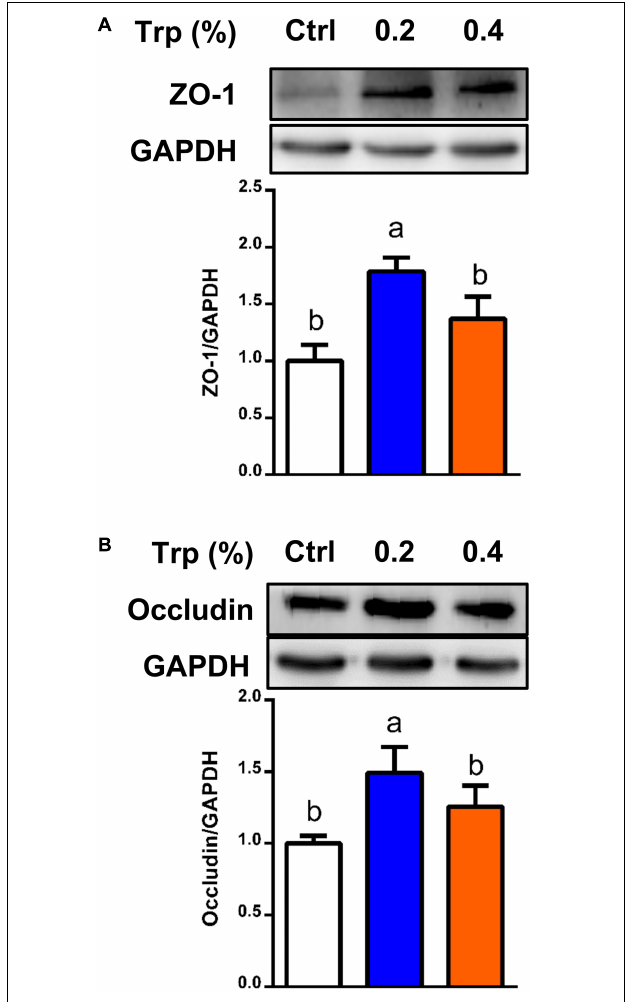
FIGURE 6 | Protein abundances of tight junction in the colon from weaned pigs in 0%, 0.2%, and 0.4% Trp groups. Data are presented on ZO-1 (A) , and occludin (B) . Values are means ± SEMs, n = 6. Means without a common letter differ, P <